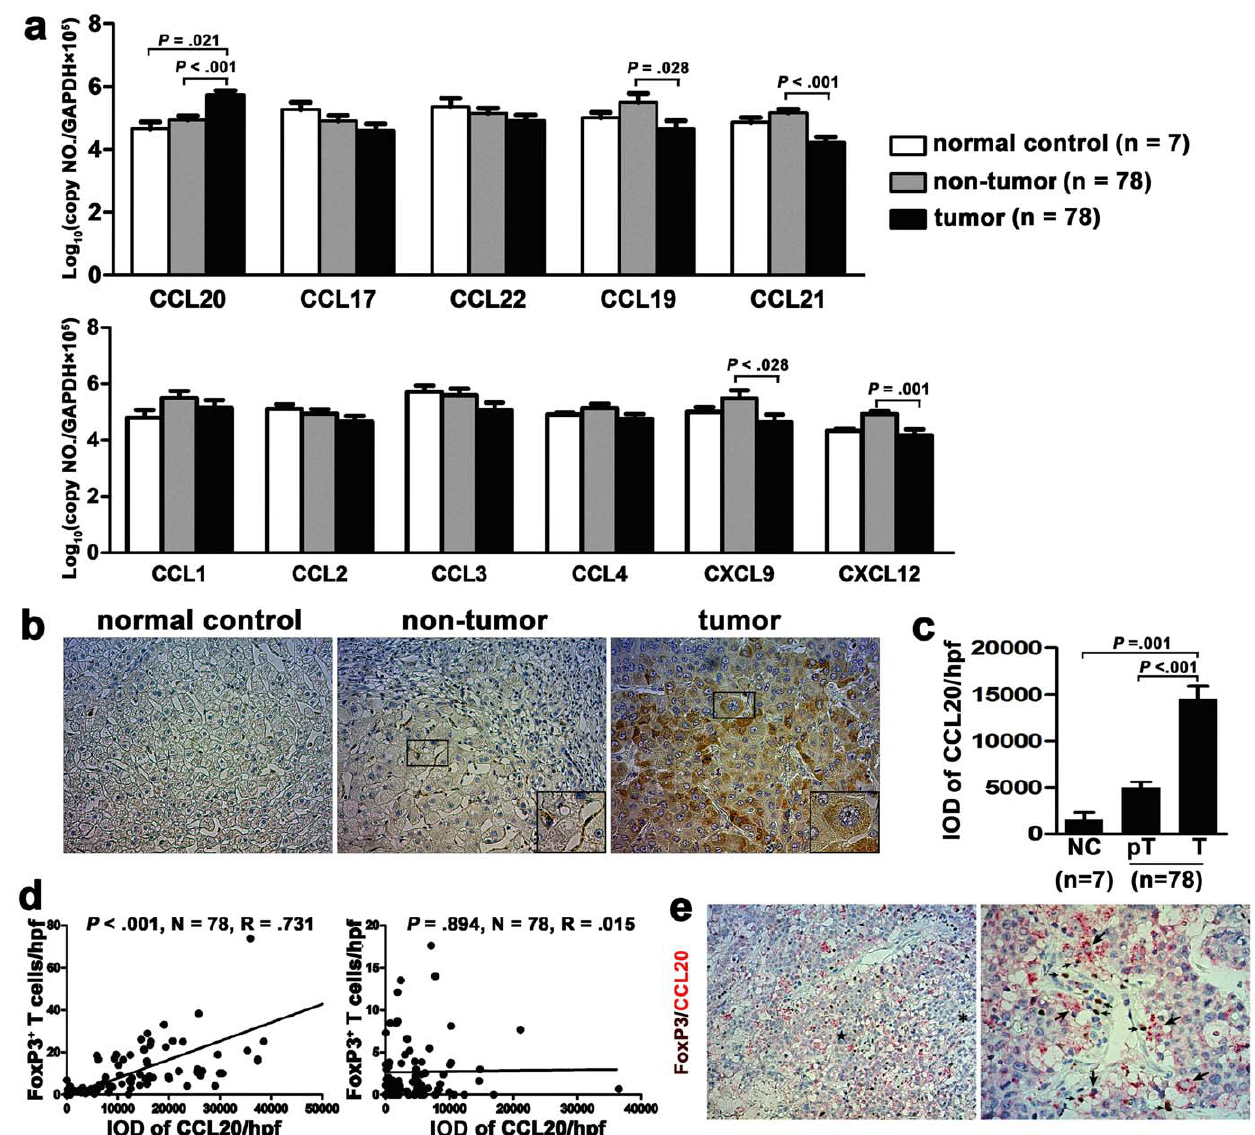
Figure 3. Increased CCL20, secreted by liver tumor cells, is associated with the number of tumor-infiltrating Tregs. (a) Real-time PCR of selective chemokines in tumor and non-tumor regions of HCC patients and in normal control liver. The value was normalized to GAPDH, multiplied by 10 5 , and log transformed. (b) immunohistochemical staining of chemokine CCL20 (brown, cytoplasm). Numerous CCL20-secreting tumor cells are seen in tumor region, and a few CCL20-secreting Kuffer cells in non-tumor region. Magnification, 6 200; insert boxes, 6 400. (c) Statistical analysis shows the CCL20 level in tumor tissue is significantly stronger than that in non-tumor and normal liver tissues. IOD, integrated optical density. (d) The correlations between CCL20 level and the number of FoxP3 + cells in tumor (left) and non-tumor (right) regions. The expression of CCL20 and FoxP3 were detected by immunohistochemical staining, and quantified as described in ‘‘Materials and Methods’’. (e) Double staining of CCL20 (red, cytoplasm) and FoxP3 (brown, nucleus). The regions expressing high and low levels of CCL20 are marked by ‘‘ w ’’ and‘‘*’’, respectively. Big arrows indicate CCL20-secreting tumor cells, and small arrows FoxP3 + cells. Magnification, 6 200, left; 6 400, right.